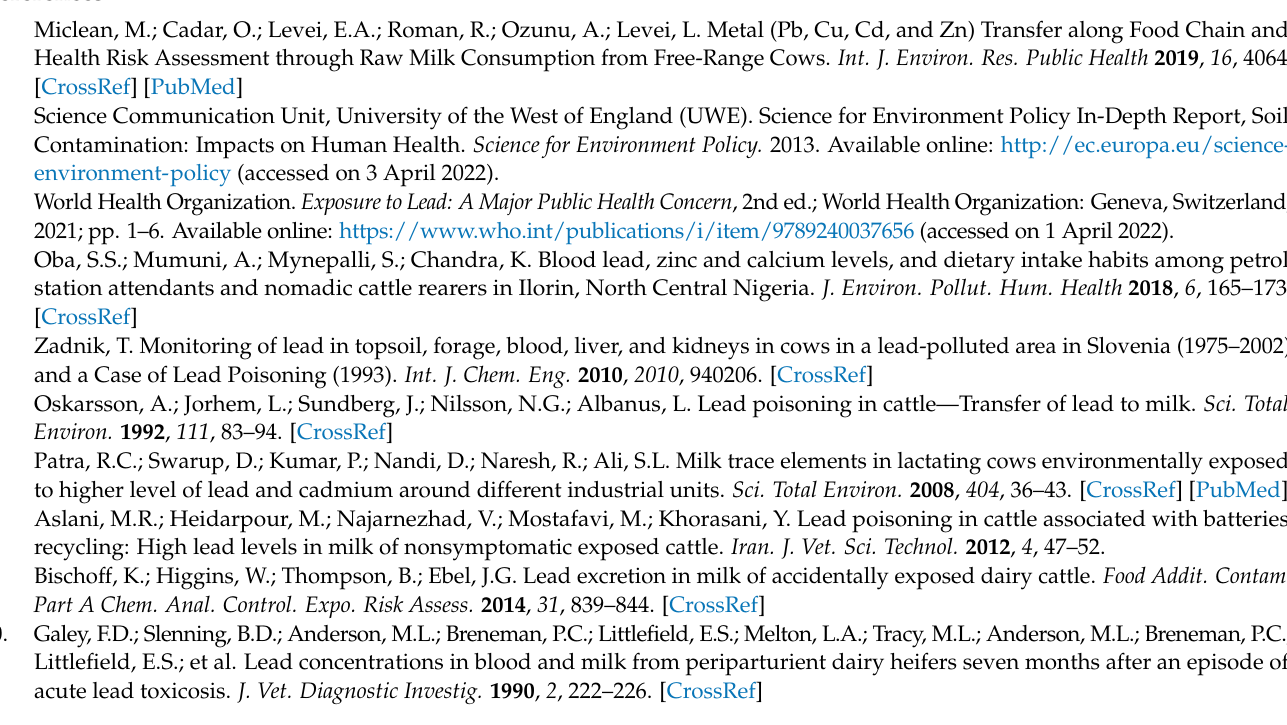
Table S4: Analytical performances of